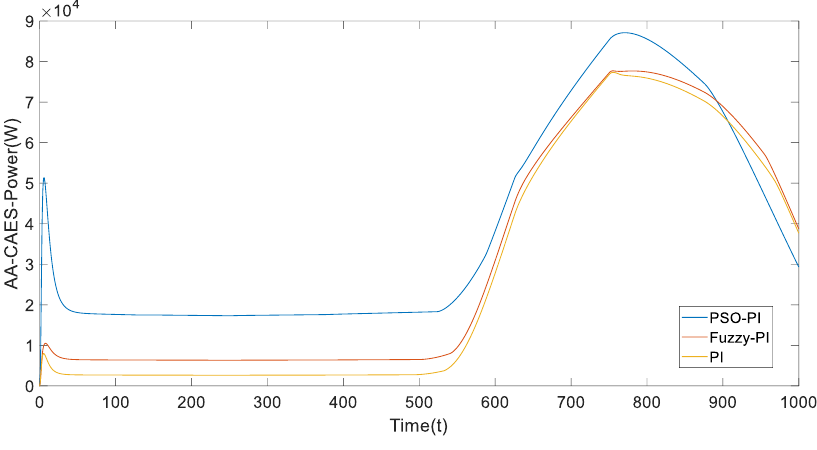
Figure 25. Output power of AA-CAES in Example 2.